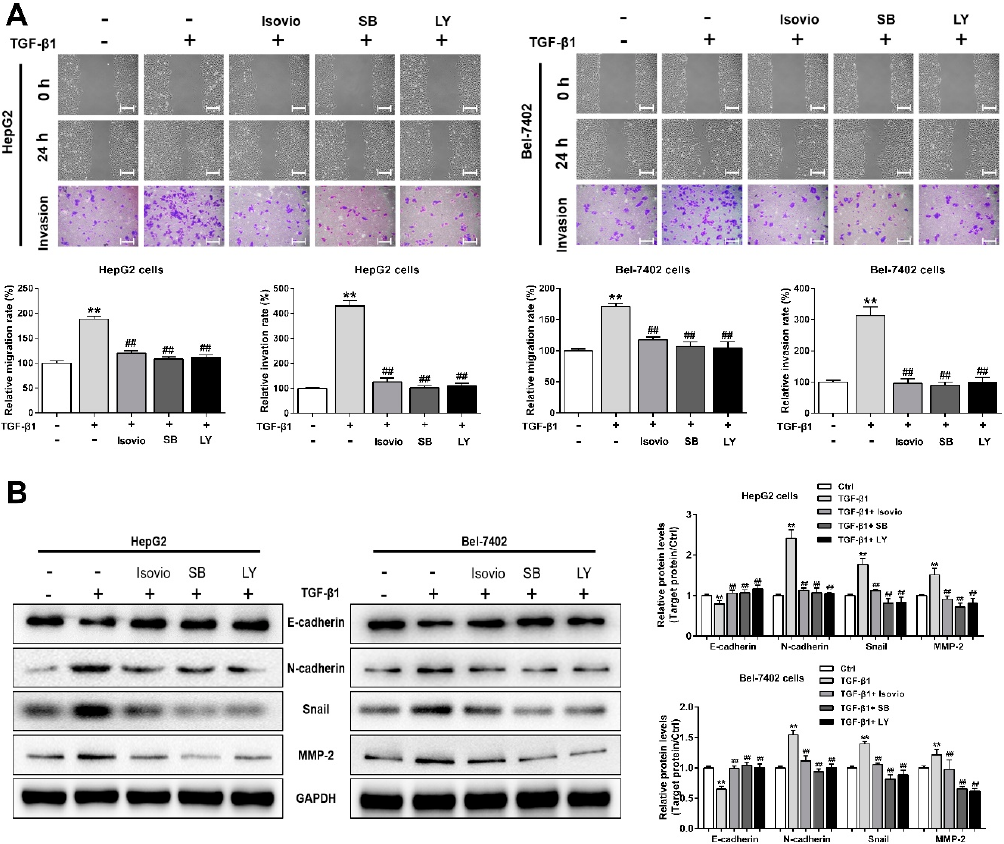
Figure 7. Verification that isoviolanthin affects TGF- β 1-induced EMT, migration, and invasion in HCC cells by regulating the TGF- β /Smad and PI3K/Akt/mTOR pathways. ( A ) HepG2 and Bel-7402 cells were pretreated with 10 ng/mL TGF- β 1 for 48 h and then treated with 10 µM isoviolanthin, 20 µM SB431542 (SB, TGF- β /Smad inhibitor), or 20 µM LY294002 (LY, PI3K/Akt inhibitor) for the last 24 h. HCC cell migration and invasion were measured by wound healing and transwell assays. Scale bars: 100 µm. ( B ) E-cadherin, N-cadherin, Snail, and MMP-2 expression in HCC cells was examined by Western blot analysis. GAPDH was used as a loading control. Representative images and bar graphs (mean ± SD) are shown, n = 3. ** p < 0.01 versus the control group; ## p < 0.01 versus the TGF- β 1 group.